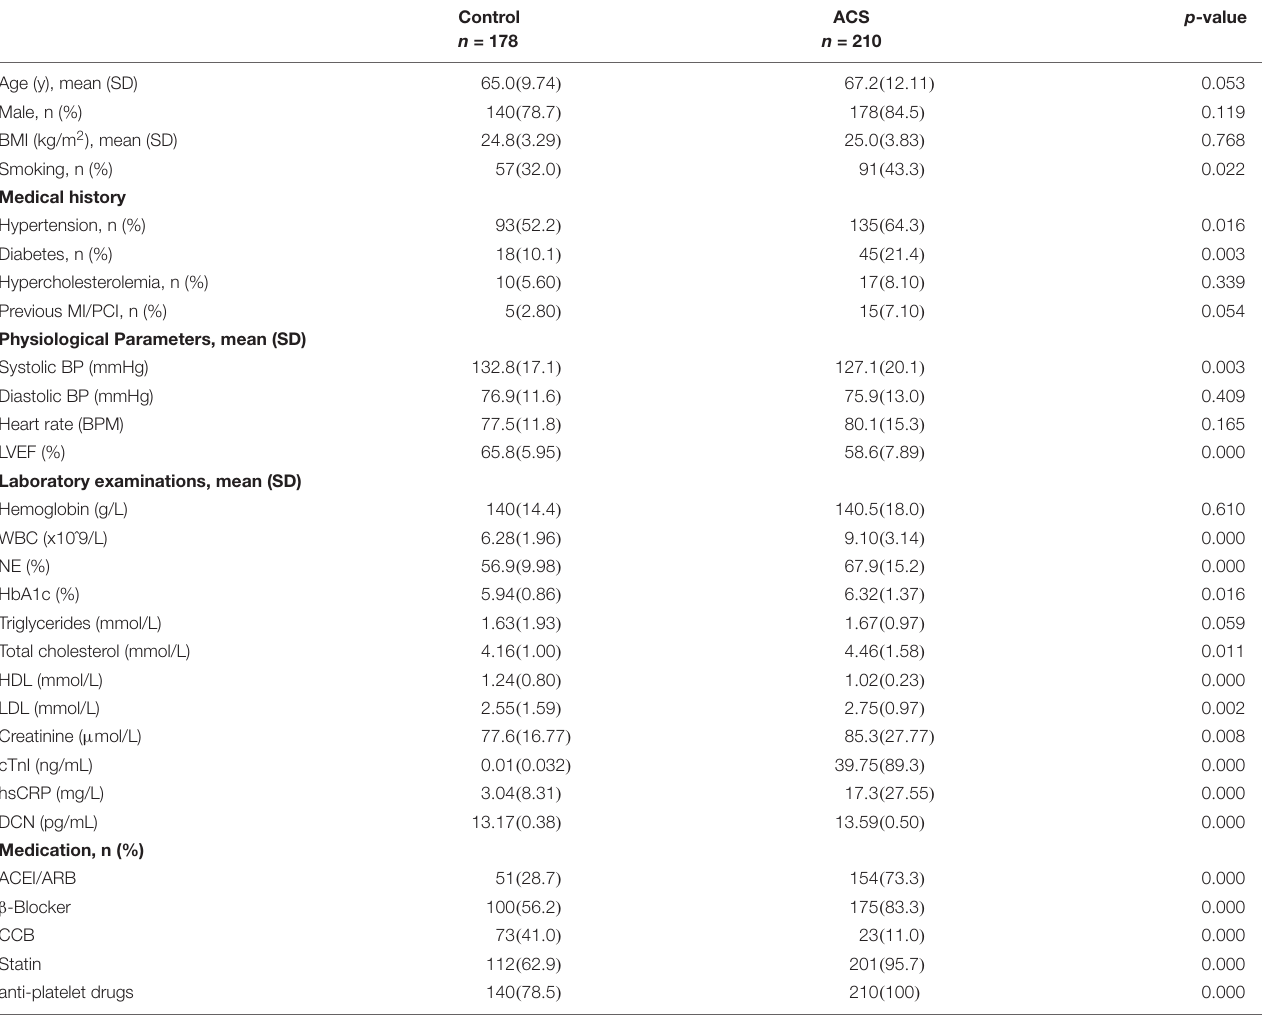
TABLE 1 | Baseline characteristics of Acute coronary syndrome (ACS) and control subjects.